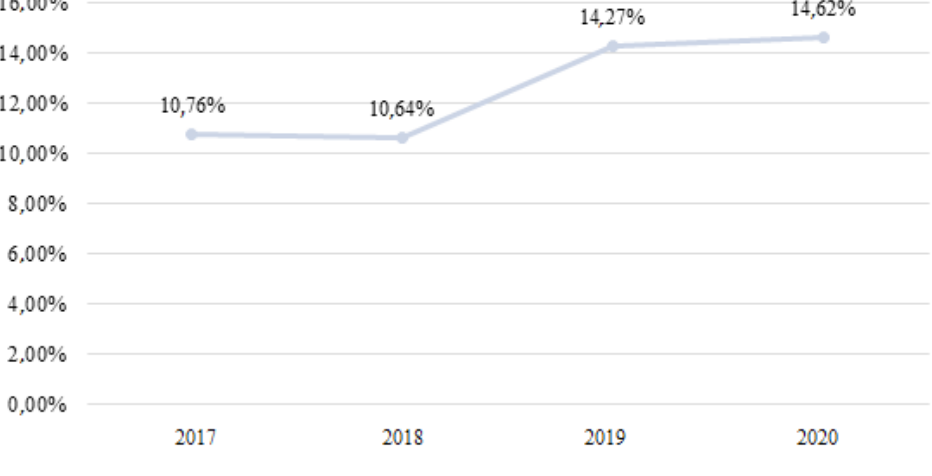
Figure 7. Long-term indebtedness of SMEs financed in the MAV